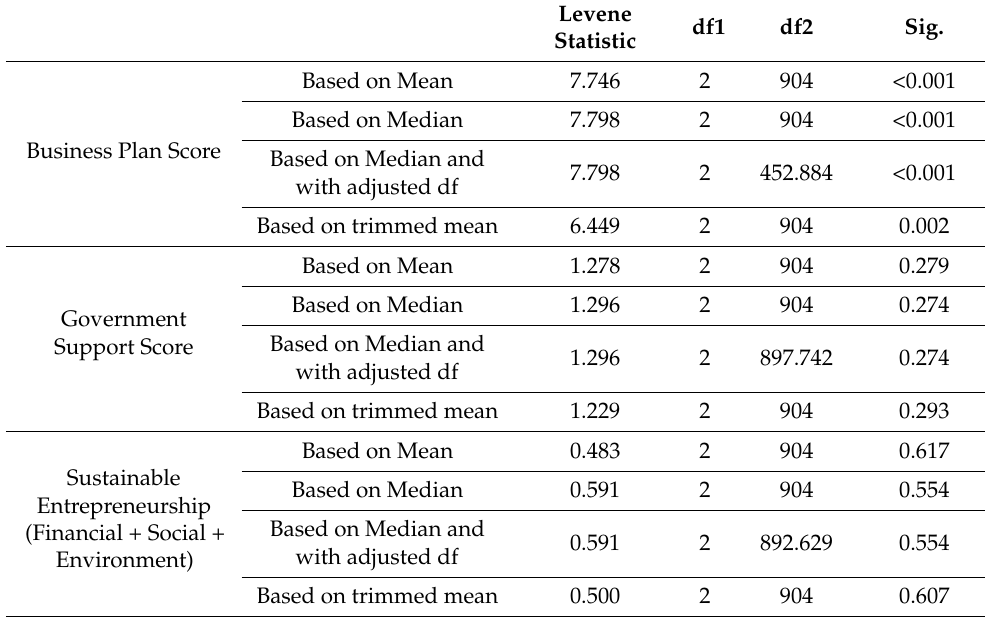
Table 9. Levene’s test of equality of error